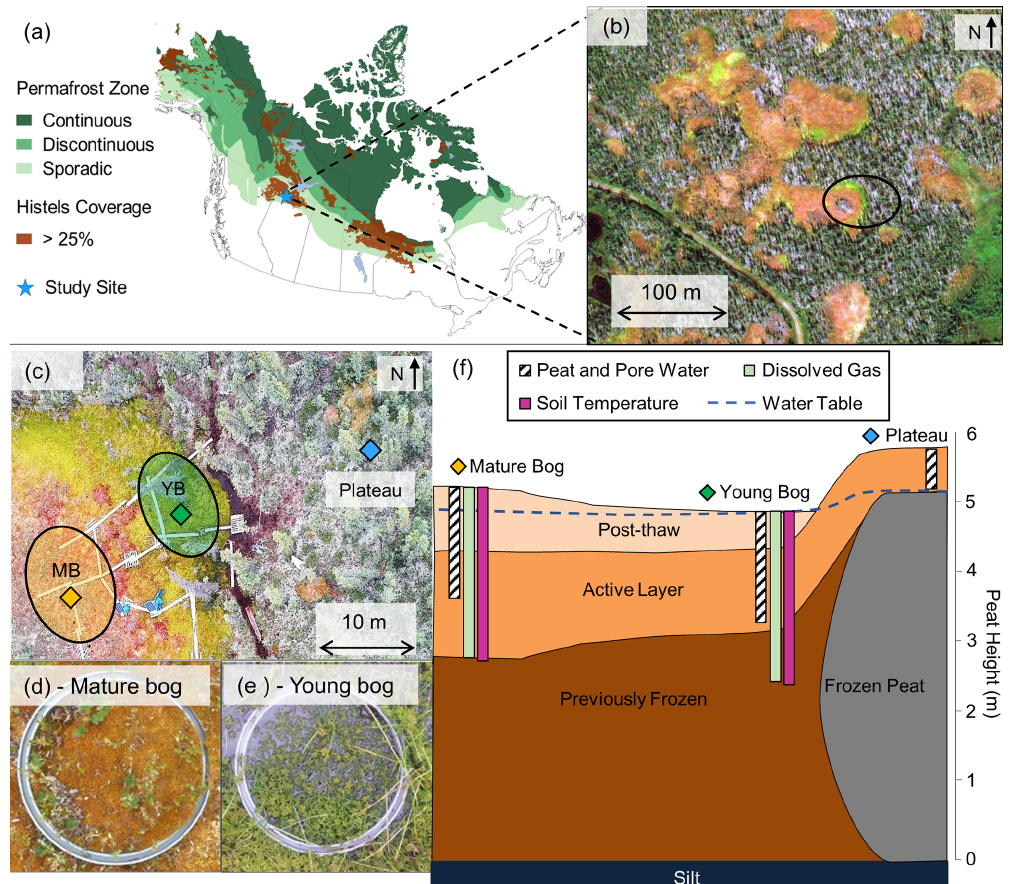
Figure 1. Lutose peatland site location and study design. (a) Site location (Lutose, Alberta, Canada; 59.5 ◦ N, 117.2 ◦ W) in boreal western Canada. Green shading represents permafrost zonation (Brown et al., 1997), and brown shading represents areas with > 25% permafrost peat- land (histels) extent (Hugelius et al., 2014). (b) GeoEye satellite image of study site (image from https://zoom.earth/, last access: 20 Novem- ber 2018) at 0.46m resolution. The circle represents the area where sampling took place. (c) Aerial image of study transect, locations of peat and dissolved gas sampling in the plateau (blue diamond), young bog (green diamond), and mature bog (orange diamond), and area where collars for gas flux measurements were located in the young bog (YB, green) and mature bog (MB, orange) (aerial photo credit: Olefeldt, David). (d, e) Surface vegetation in the mature bog and young bog and (f) soil profile of thaw transect based on Heffernan et al. (2020). The transition to post-thaw peat occurs at 29 and 71cm in the young bog and mature bog, respectively. Peat (core) and pore water (pore water peepers), including microbial community, sampling depth profile for 0–160cm shown as white column with diagonal black lines. Dissolved gas (diffusive samplers) sampling depth profile for 0–245cm shown as light green column. Soil temperature depth profile for 0–250cm shown as purple column. Average water table depth shown as dashed blue